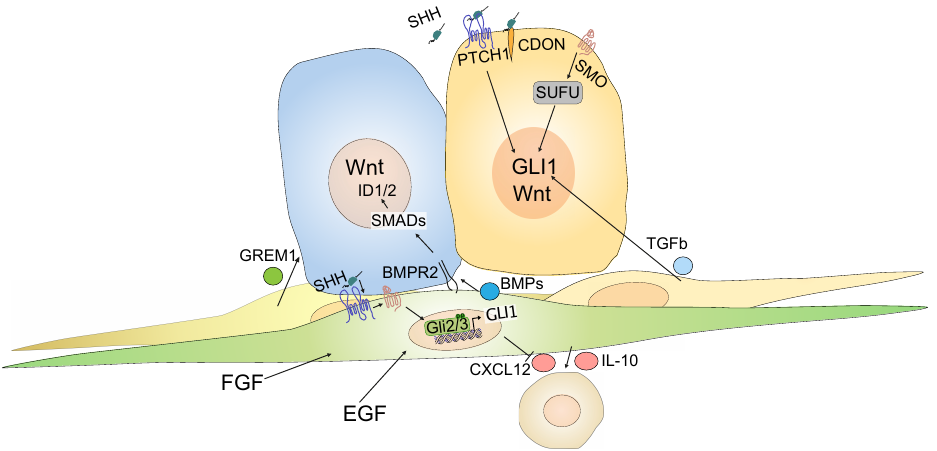
Figure 3. Epithelial vs. stromal Hedgehog signaling in colorectal cancer. Most tumor cells are characterized by high Wnt signaling levels, but some may produce Hh ligands (blue cell), e.g., SHH. A Hh responsive stromal cell (green) receives the ligand via PTCH1 and SMO (“canonical” Hh signaling). Most stromal cells (in the background) do not respond to Hh ligands. The receptive stromal cells respond by secreting, e.g., BMP ligands, which act via BMP receptors (e.g., BMPR2) and SMADs on the tumor cell side to activate pro-differentiating ID1 and ID2; conversely, tumor cells are exposed to BMP inhibitors such as GREM1, secreted by other stromal cells. In addition, some GLI1-expressing cells secret immunomodulating factors, such as IL-10, or seize secreting CXCL12, possibly impacting on inflammatory cells of the tumor microenvironment. Hh signaling strength can independently be modified by other factors, such as EGF and FGF, although their influence on the stromal Hh response in cancer is less clear than that in development. Other tumor cells (yellow